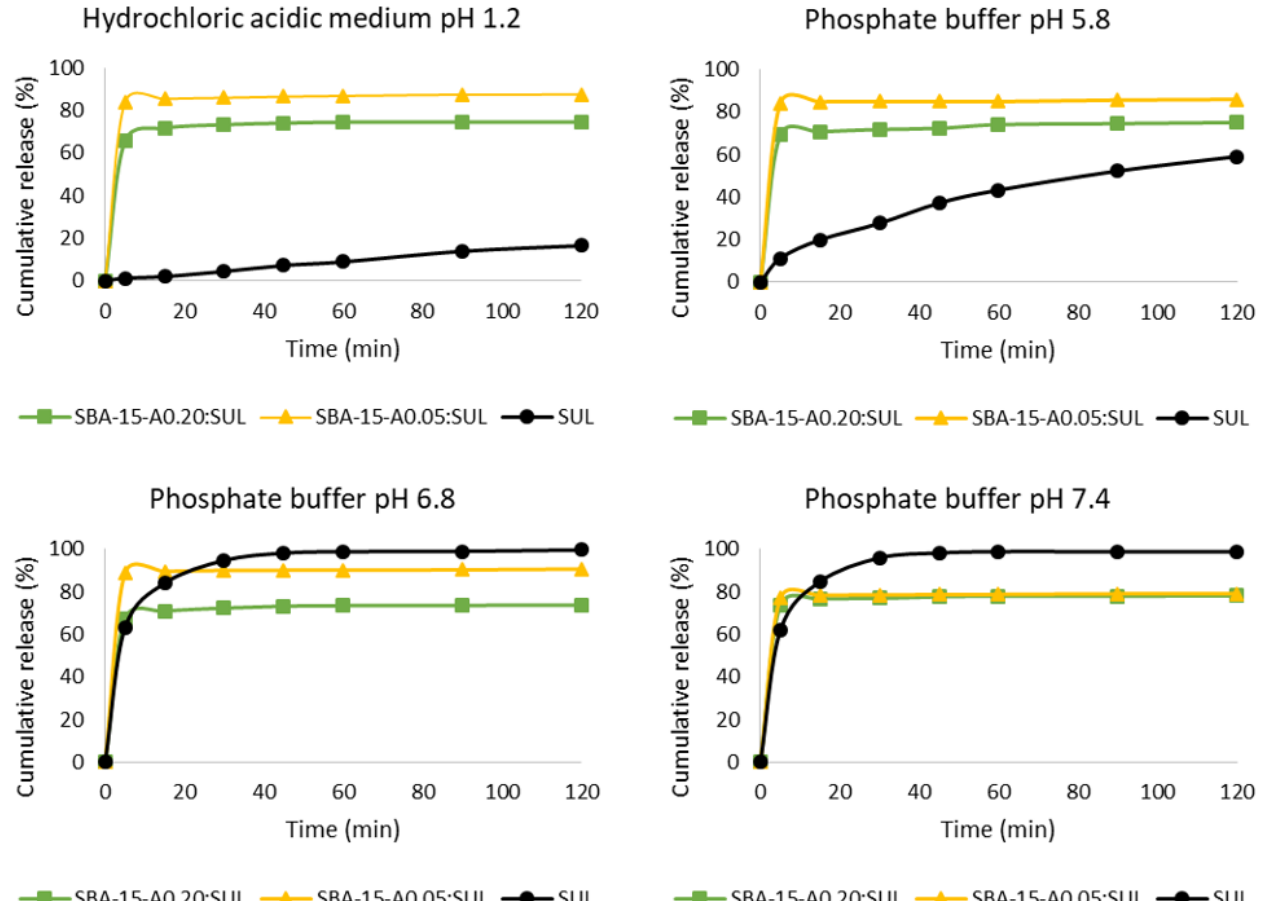
Figure 7. Dissolution profiles of SUL, SBA ‐ 15 ‐ A 0.20 :SUL, and SBA ‐ 15 ‐ A 0.05 :SUL.